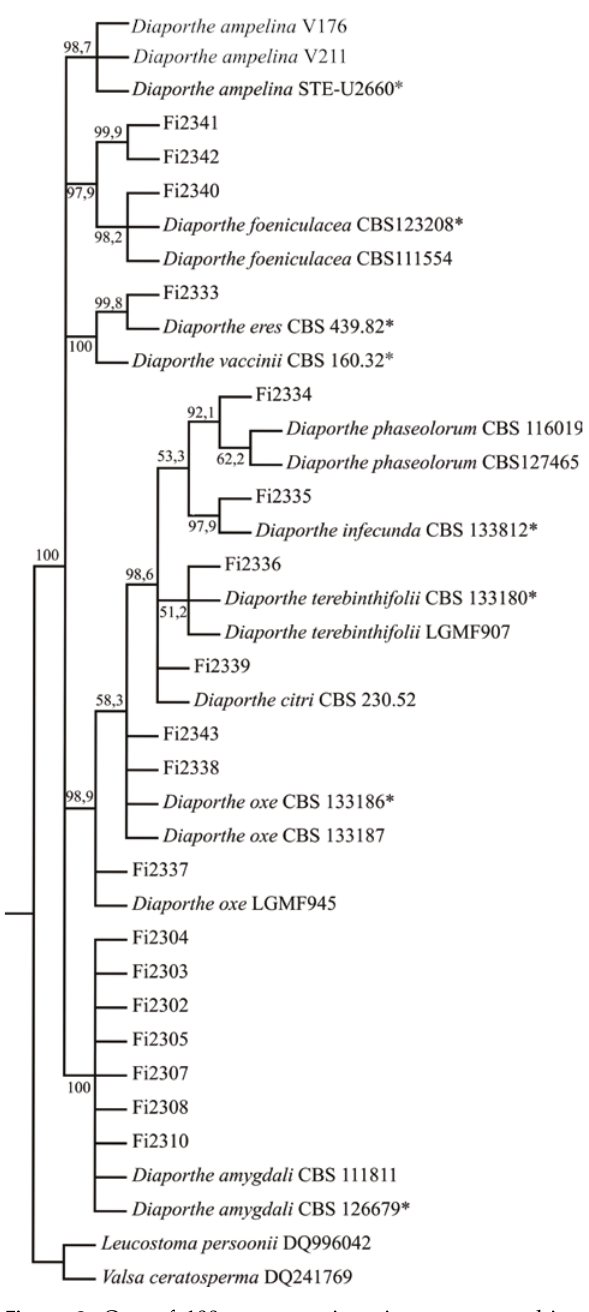
Figure 2. One of 100 most parsimonious trees resulting from the analysis of the internal transcribed spacer (ITS) sequences from fungal isolates. Maximum-parsimony bootstrap support values based on 1,000 replicates are shown in the nodes. Ex-type isolates are highlighted with an asterisk. The tree is rooted with Leucostoma persooni (DQ996042) and Valsa ceratosperma (DQ241769)